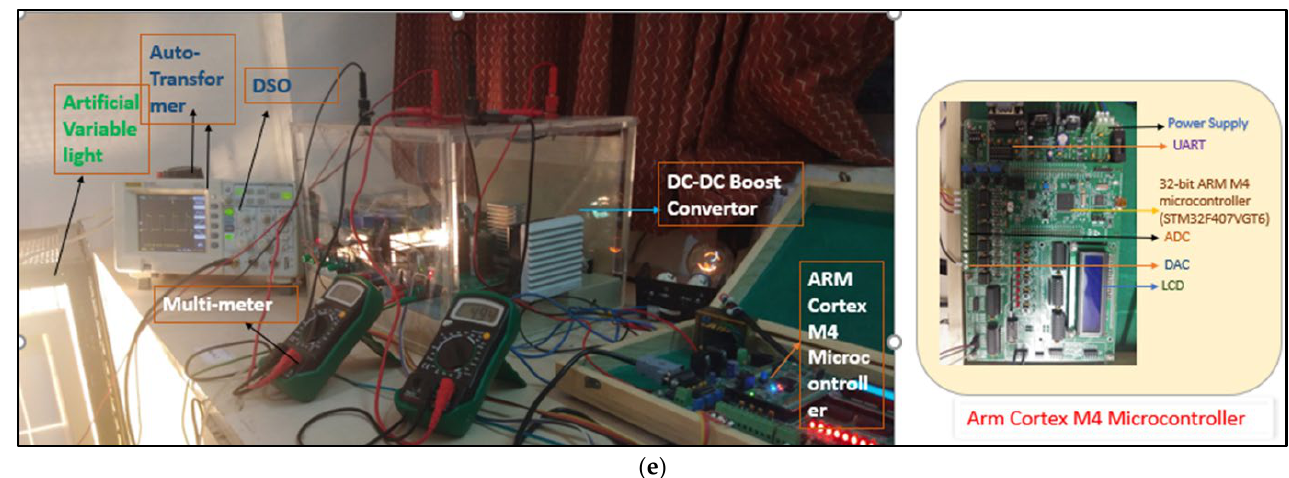
Figure 16. ( a ) Duty cycle vs. time; ( b ) output parameters; ( c ) real-time I–V and P–V characteristics without partial shading (PS) and drift; ( d ) real-time I–V and P–V characteristics with partial shading (PS) and drift; ( e ) Hardware structure.